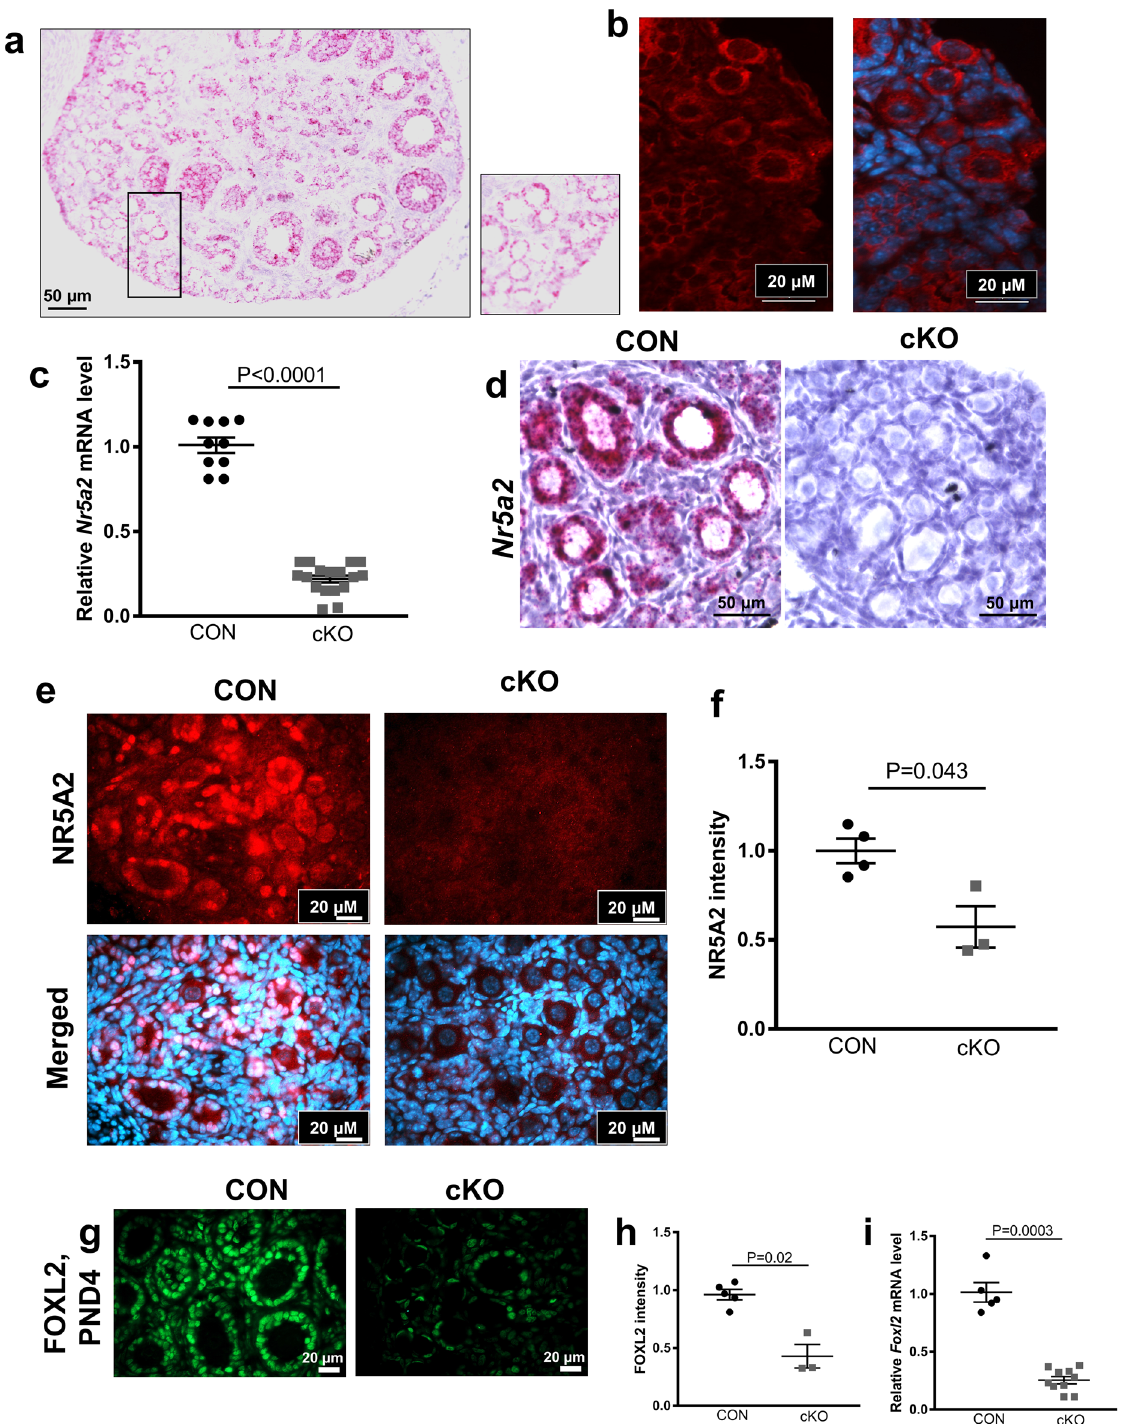
Figure 1. Depletion of NR5A2 from knock-out (cKO) ovaries at the termination of primordial follicle formation, via AMRH2-cre. ( a ) RNA in situ hybridization of Amhr2 in CON ovaries at PND6. ( b ) Immunolocalization of AMHR2 in the ovaries of PND13 CON mice. ( c ) Abundance of Nr5a2 transcripts in CON and cKO mouse ovaries at PND4 (n = 5–10 per genotype). ( d ) RNA in situ hybridization of Nr5a2 in CON and cKO ovaries at PND6. ( e ) Immunolocalization of NR5A2 in PND4 CON and cKO mouse ovaries. Quantitative analysis of NR5A2 expression in CON and cKO PND4 mouse ovaries (n = 3–6 animals per genotype). ( f ) Quantification of signal from immunofluorescence in CON and cKO mouse ovaries on PND4. ( g ) Localization of FOXL2 in CON and cKO mice ovaries at PND4 showing absence of FOXL2 signal in primordial follicles of the cKO mouse. ( h ) Quantitative analysis of FOXL2 expression between CON and cKO PND4 mice ovaries (n = 3–5 animals per genotype). ( i ) Abundance of Foxl2 transcripts in CON and cKO mice ovaries at PND4 (n = 5–10 animals per genotype). Quantification or protein expression for NR5A2 and FOXL2 was performed using CellProfiler version 4.06, www.cellp rofil